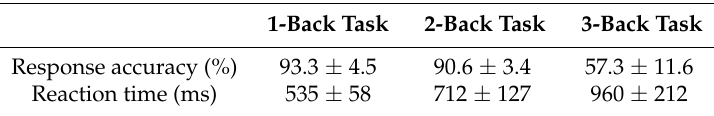
Table 3. Average performance including the response accuracy and the reaction time of the ten subjects during the 1-, 2-, 3-back